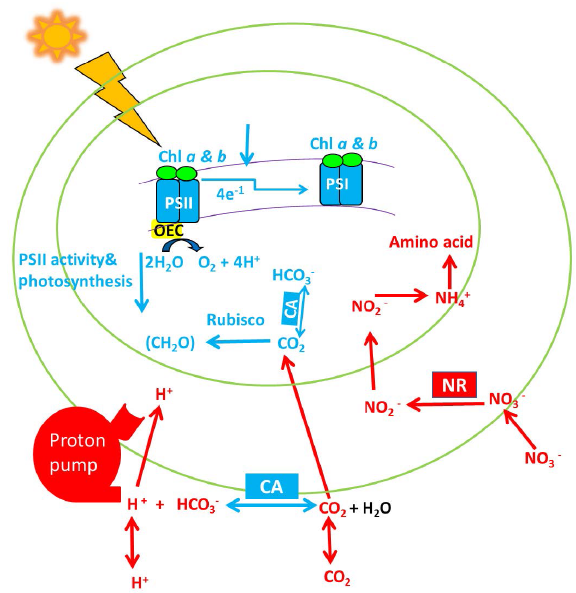
Figure 8. Physiological responses of U. linza to the combination of ocean acidification and nutrient availability. The blue and the red symbols represent down- and up-regulated metabolic pathways re- spectively. PSI: Photosystem I; PSII: Photosystem II; OEC: oxygen- evolving complex; NPQ: non-photochemical quenching; CA: car- bonic anhydrase; NR: nitrate